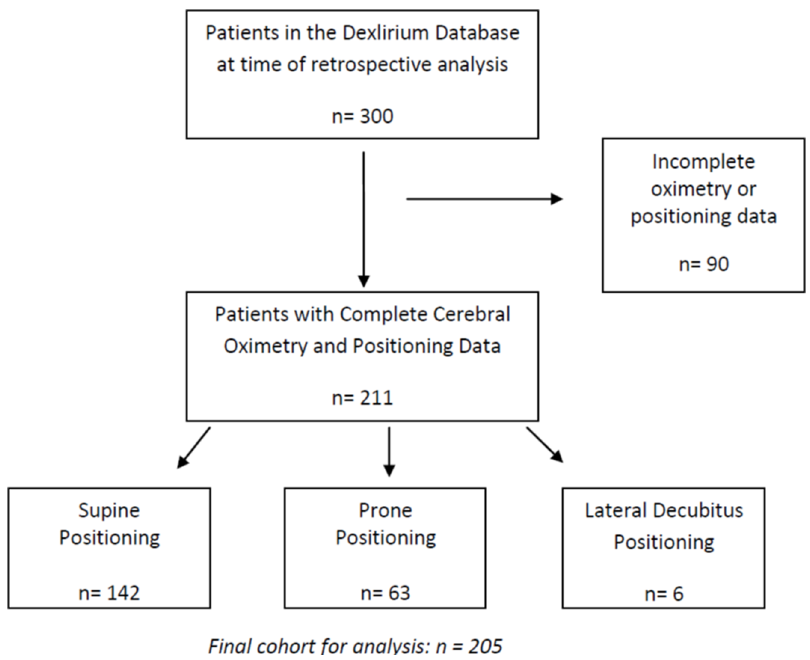
Figure 1. Study Population and Exclusion Criteria.